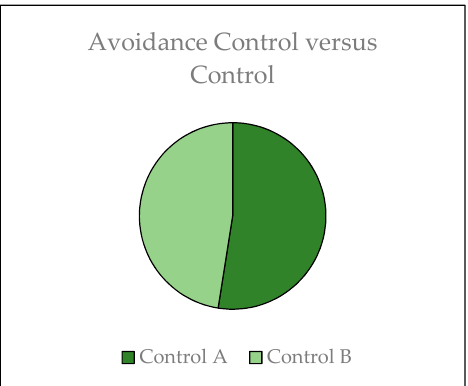
Figure 6. Enchytraeid avoidance distribution for both sides with control soil.